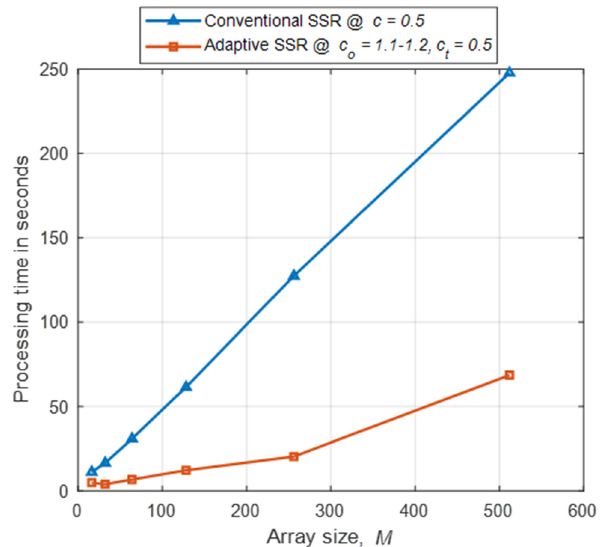
Figure 9. Processing time variation with the array size for the conventional and adaptive SSR algo- rithms.